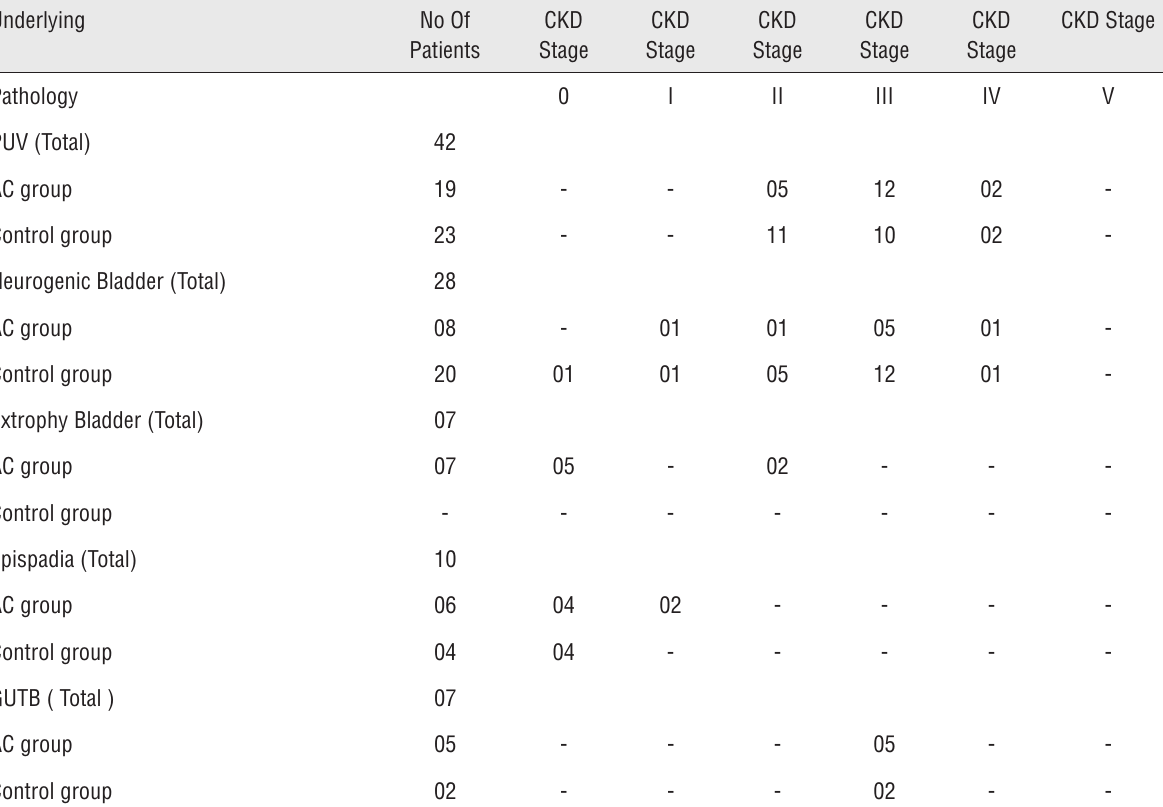
Table 2 - Baseline Renal Function and underlying Pathology (AC group/ Control group). Underlying No Of